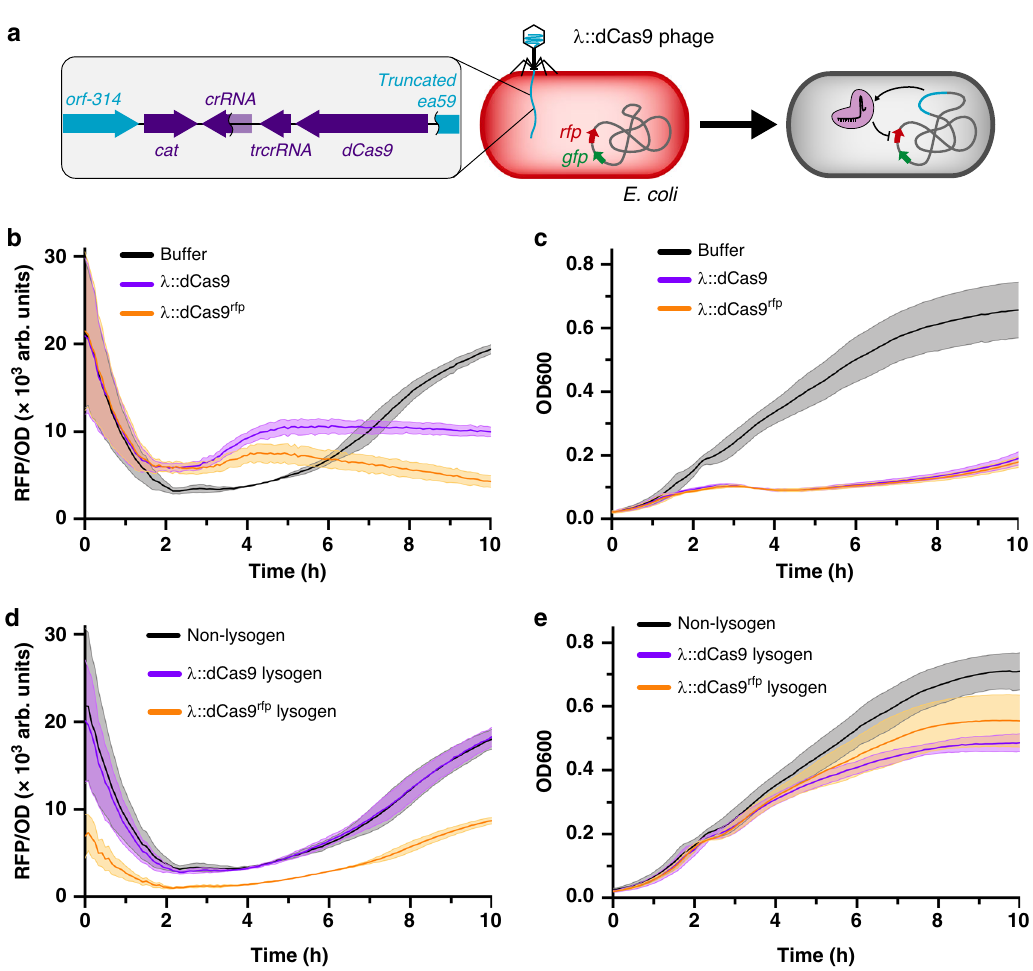
Fig. 2 In vitro gene repression by λ ::dCas9 rfp . Scheme of in vitro experiment examining repression by engineered λ phage ( a ). E. coli cultures mixed with phage buffer, λ ::dCas9 phage, or λ ::dCas9 rfp phage tracked for RFP fl uorescence ( b ) and bacterial density ( c ). Non-lysogenic, λ ::dCas9 lysogenic, or λ :: dCas9 rfp lysogenic E. coli cultures tracked for RFP fl uorescence ( d ) and bacterial density ( e ). Lines represent means and shaded regions represent standard errors. Source data are provided as a Source Data fi